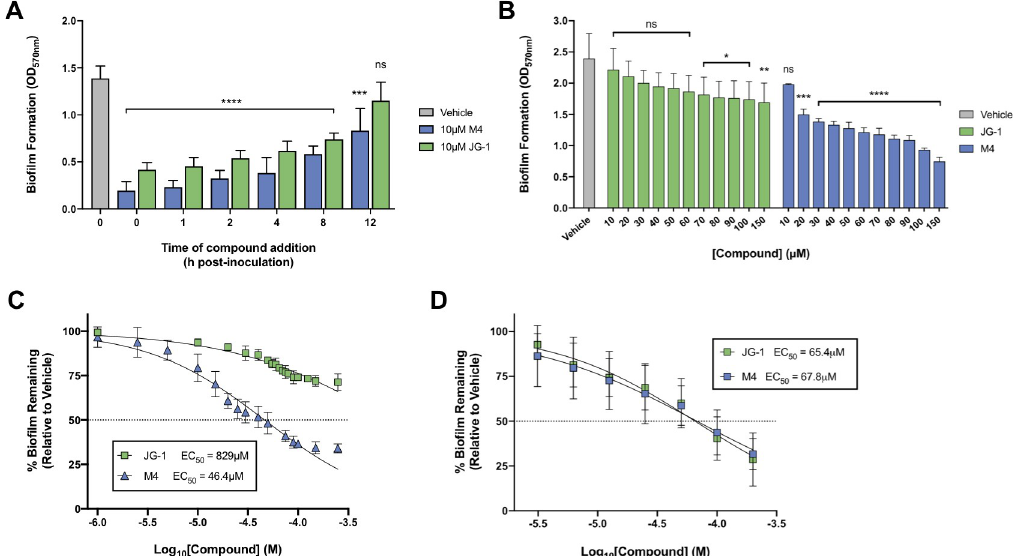
Fig 3. Disruption of preformed Salmonella biofilms by JG-1 and M4. A. Addition of JG-1 or M4 to developing S . Typhimurium biofilms suggests anti-biofilm activity decreases as biofilm development progresses. At either the time of inoculation (0h post-inoculation) or at various timepoints 1–12 h post-inoculation, JG-1 or M4 was added to the media of S . Typhimurium biofilms to achieve a final compound concentration of 10 μ M. Biofilms were incubated for a total of 24 h, after which biofilm formation relative to a vehicle control (DMSO) was assessed via crystal violet assay. Annotations above the data denote values that are significantly different from the vehicle control (gray bar), as determined by two-way ANOVA with Dunnett’s test for multiple comparisons; ns p � 0.05, ��� p < 0.001, ���� p < 0.0001. B. Untreated S . Typhimurium biofilms were grown for 24h, after which media was removed and replaced with various concentrations (10–150 μ M) JG-1 or M4 or a vehicle control (DMSO). Incubation was resumed for an additional 24 h, after which biofilm formation was assessed via crystal violet assay. Annotations above the data denote values that are significantly different from the vehicle control (gray bar), as determined by two-way ANOVA with Dunnett’s test for multiple comparisons; ns p � 0.05, � p < 0.05, �� p < 0.01, ��� p < 0.001, ���� p < 0.0001. C. S . Typhimurium biofilms were grown and treated as described in B and EC 50 values for biofilm disruption with JG-1 [829.4 μ M (95% CI, 608.1 μ M–1.2 mM)] and M4 [46.4 μ M (95% CI, 41.6–52.1 μ M)] were calculated using GraphPad Prism 8 to plot normalized compound activity (percent biofilm remaining) as a function of log 10 drug concentration and fitting the dose response curve (log[inhibitor] vs. normalized response, variable slope). D. S . Typhi biofilms were grown in cholesterol-coated microtiter plates for 96h, then treated with a vehicle control (DMSO) or various concentrations